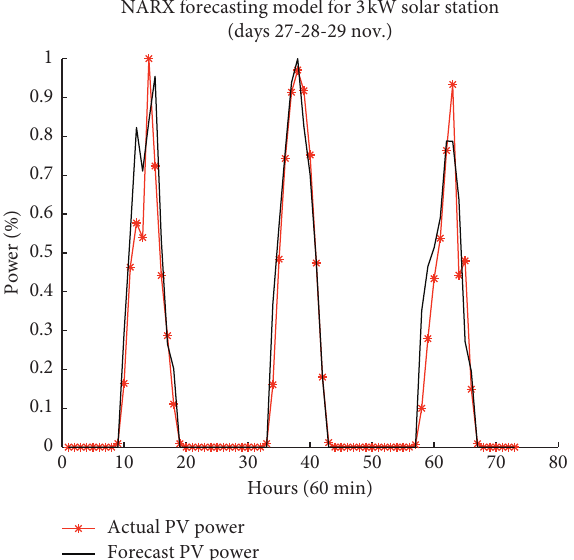
Figure 13: NARX neural network for forecasting days 27, 28, and 29 November of the year.